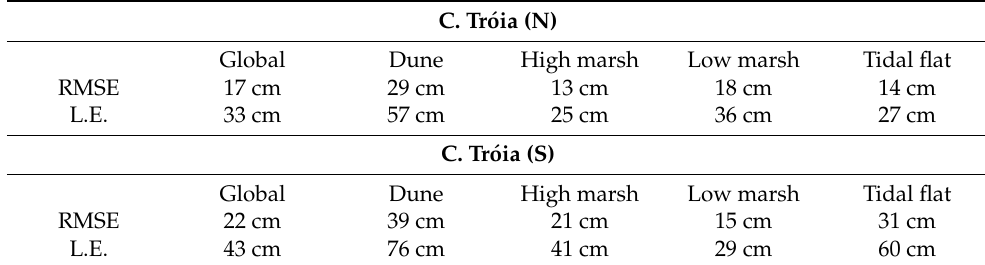
Table 3. RMSE and L.E. of C. Tr ó ia (N) and (S) salt marshes DTM.